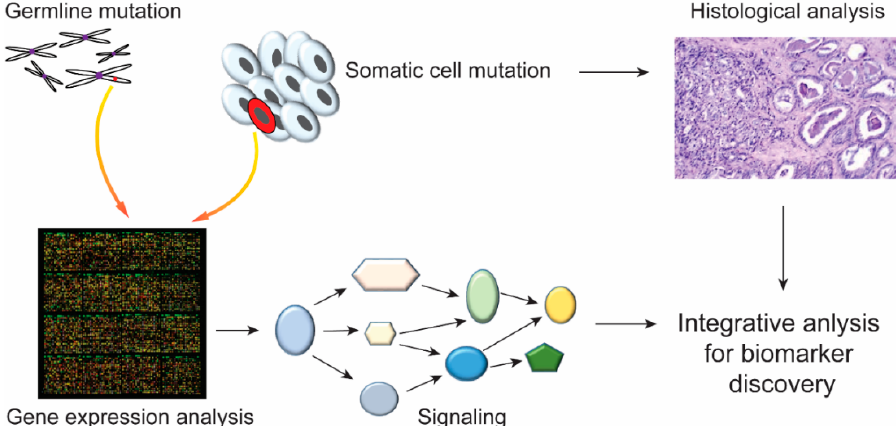
Figure 5. Integrated analysis of germline and somatic mutations. The mutation in germline and somatic cells can be tested by high-throughput sequencing techniques at the genetic or transcript level. Integrated analyses of disease-related gene expression or pathways combined with histological data might contribute to the identification of biomarkers for disease diagnoses and treatment.